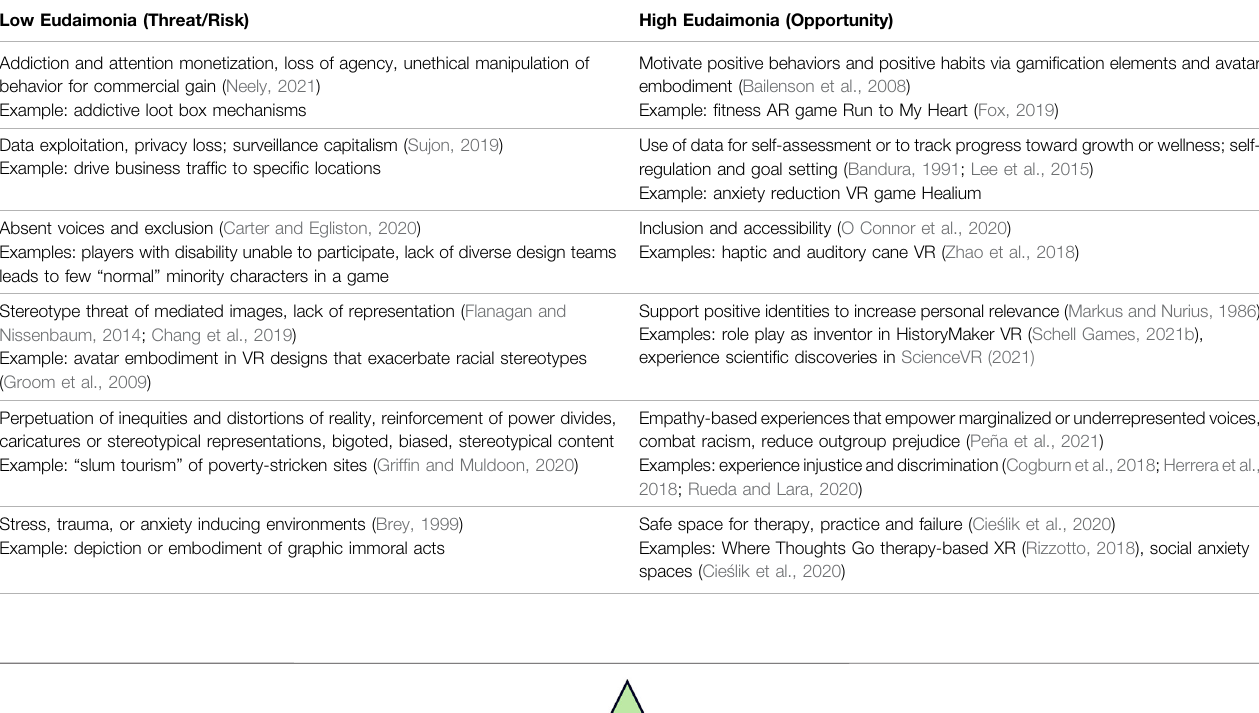
TABLE 4 | Examples of Low vs High Eudaimonic Design Opportunities.